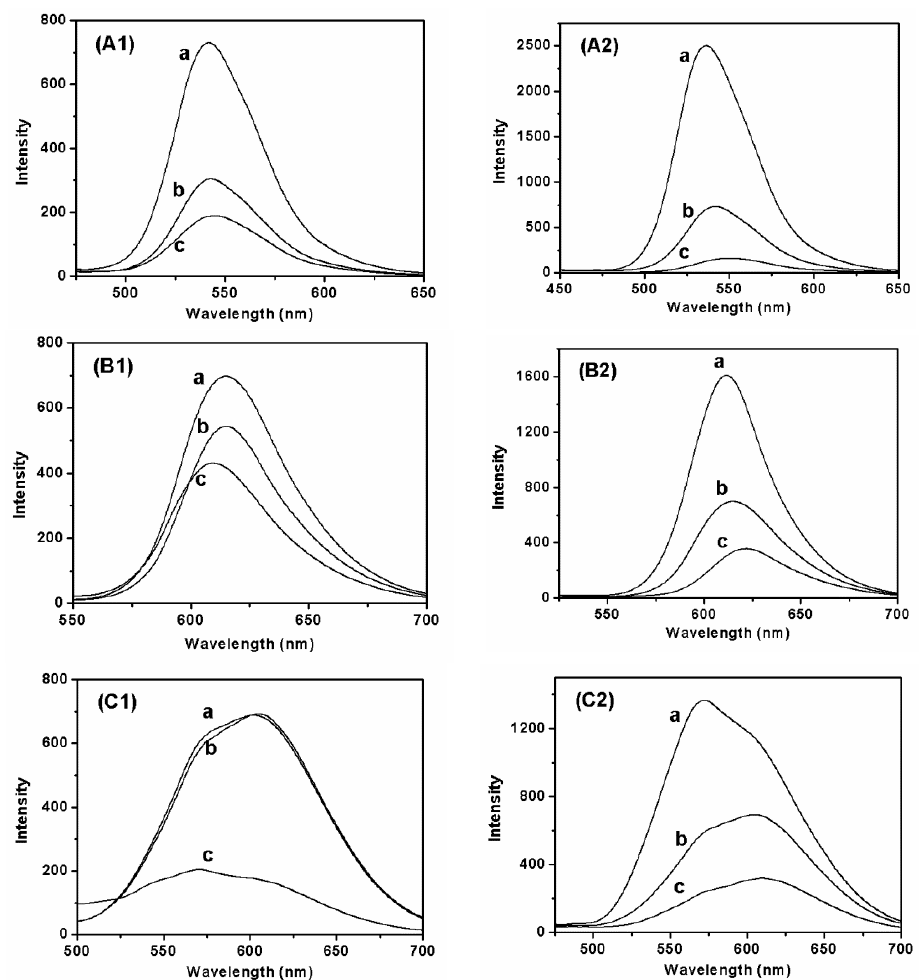
Figure 9. Fluorescence intensity of fluorescent SF nanofibers with different types of fluorescent dyes: ( A1 , A2 ) FS, ( B1 , B2 ) RB, ( C1 , C2 ) AO. ( A1 , B1 , C1 ) The concentration of SF is ( a ) 10.0 wt%, ( b ) 8.0 wt%, and ( c ) 6.0 wt%. ( A2 , B2 , C2 ) The concentration of fluorescent dyes is ( a ) 0.5 wt%, ( b ) 1.0 wt%, and ( c ) 2.0 wt%.